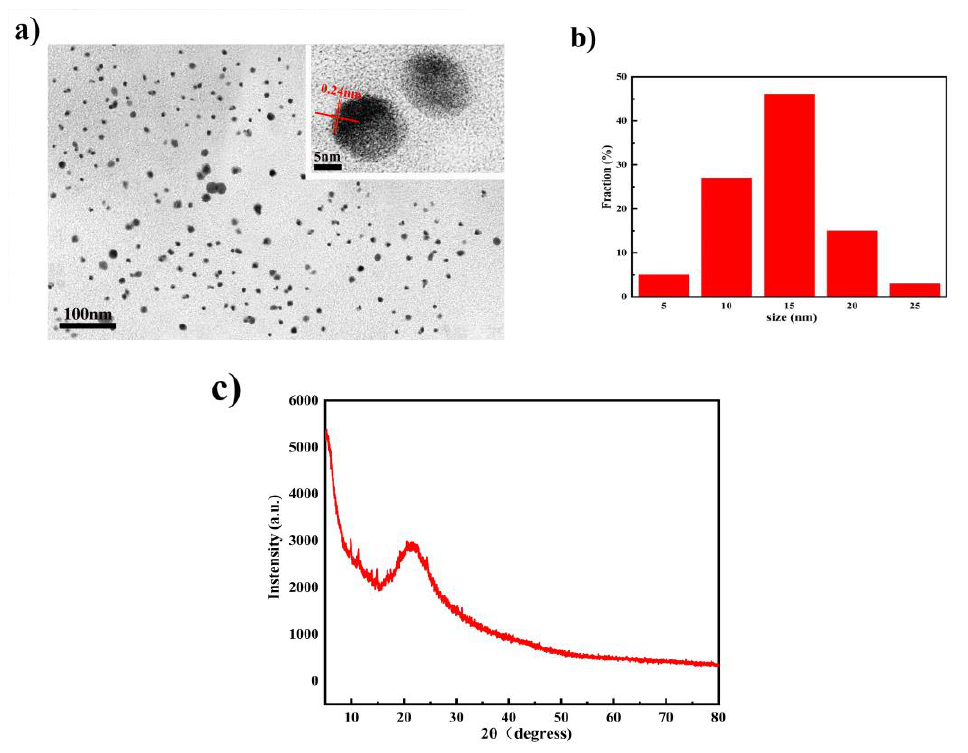
Figure 2. ( a ) The morphology of the Si,N-CQDs. ( b ) Size distribution histogram of Si,N-CQDs. ( c ) XRD diffractogram of Si,N-CQDs.